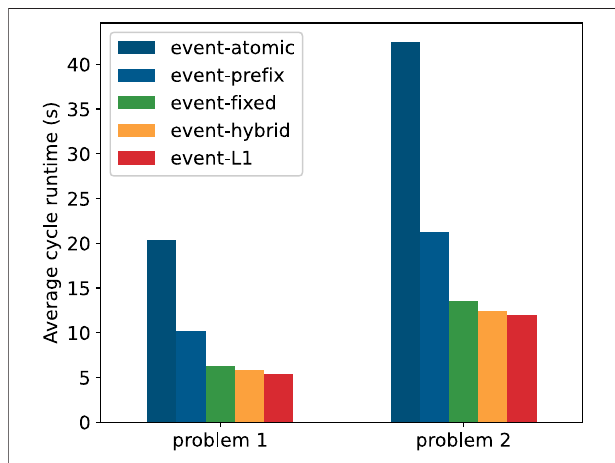
FIGURE 4 | Average cycle runtime of different event-GPU algorithms on problem 1 and problem